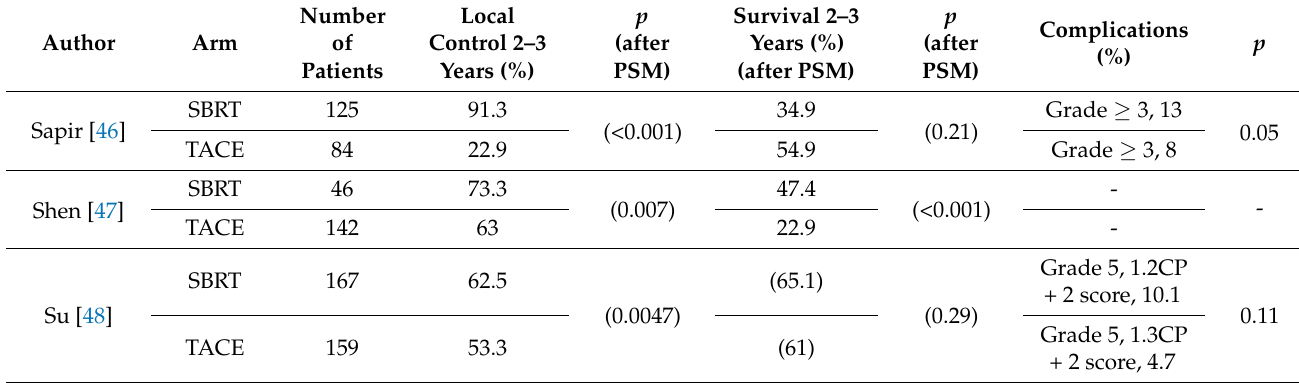
Table 6. SBRT versus TACE: Retrospective